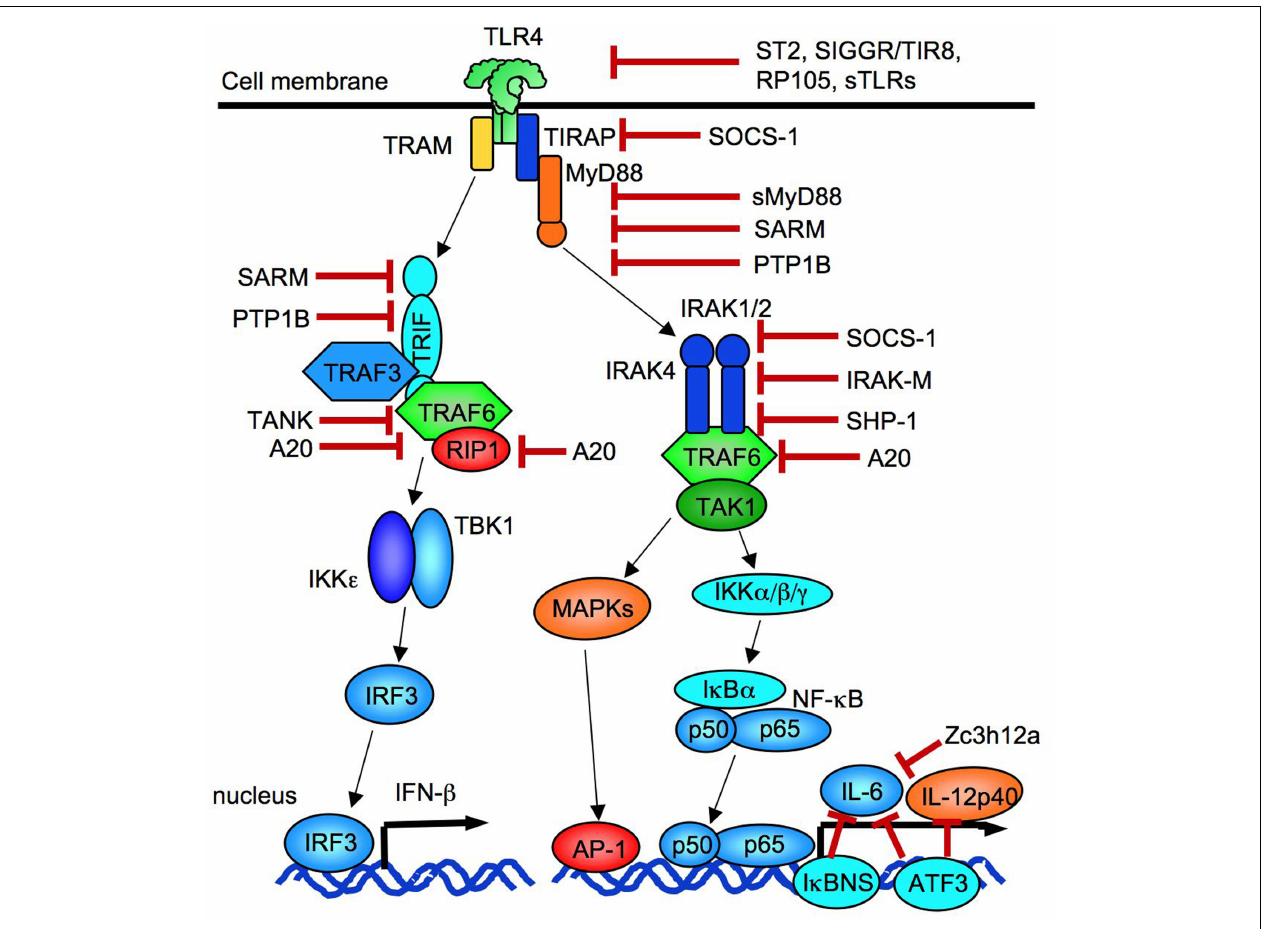
and PTP1B. SOCS-1 and IRAK-M suppresses IRAKs. A20 blocksTRAF6 and RIP1. IL-6 transcription is negatively regulated by I κ BNS, Zc3h12a, and ATF3. ATF3 also blocks IL-12p40